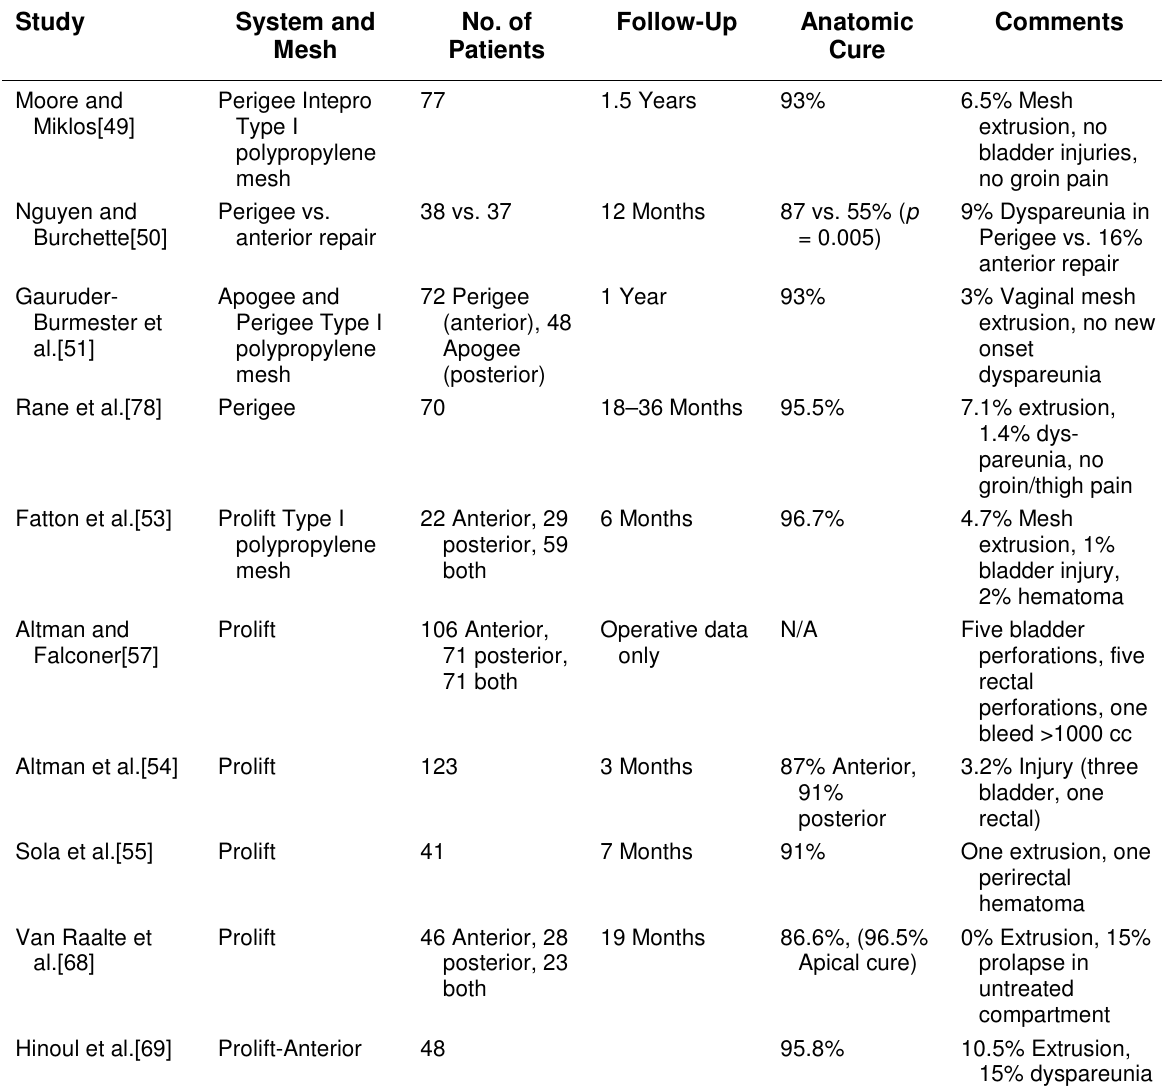
New Mesh Kits for